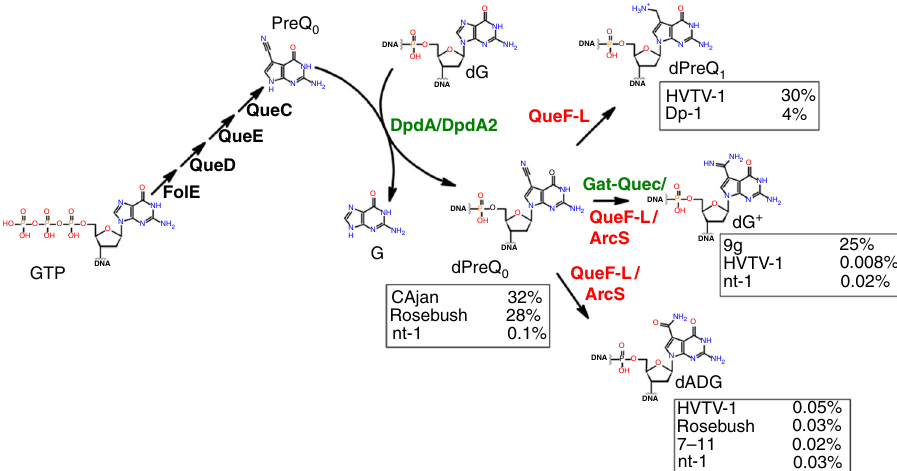
Fig. 6 Proposed synthesis pathway for the 2 ′ -deoxy-7-deazaguanine modi fi cations identi fi ed in this study. The percentages of modi fi cations identi fi ed for each phage are shown in boxes next to the modi fi cation of interest. Protein names in green are the reactions identi fi ed in this study. In red are the proposed reactions. Molecule abbreviations: guanosine tri-phosphate (GTP), 7-cyano-7-deazaguanine (preQ 0 ), 2 ′ -deoxy-7-cyano-7-deazaguanosine (dPreQ 0 ), guanine (G), 2 ′ -deoxyguanosine (dG), 2 ′ -deoxy-7-aminomethyl-7-deazaguanosine (dPreQ 1 ), 2 ′ -deoxy-7-amido-7-deazaguanosine (dADG), and 2 ′ - deoxyarchaeaosine (dG +